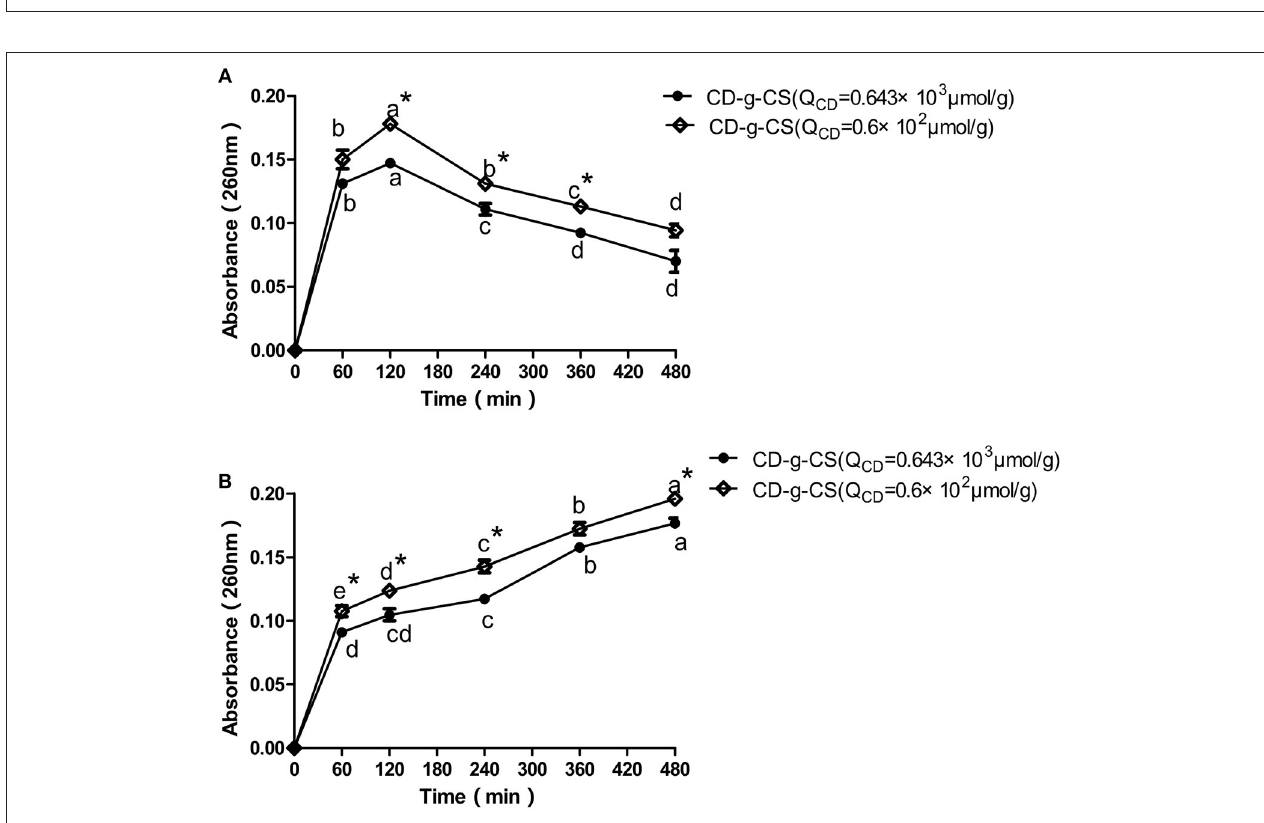
FIGURE 4 | Release of intracellular components of E. coli (A) and S. xylosus (B) suspensions treated with 10 mg/mL of CD-g-CS (Q CD = 0.643 × 10 3 µ mol/g) and CD-g-CS (Q CD = 0.6 × 10 2 µ mol/g). Different letters indicate a significant difference within groups at p ≤ 0.05 . *Indicates a significant difference between the control and CD-g-CS (Q